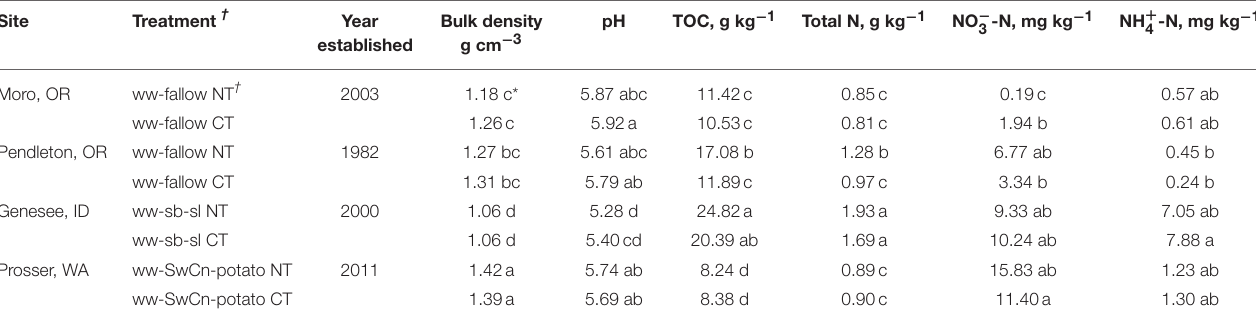
TABLE 1 | Site crop rotations and soil properties (0–10cm depth) at no-tillage and conventional tillage winter wheat plots across inland Pacific Northwest. Site Treatment